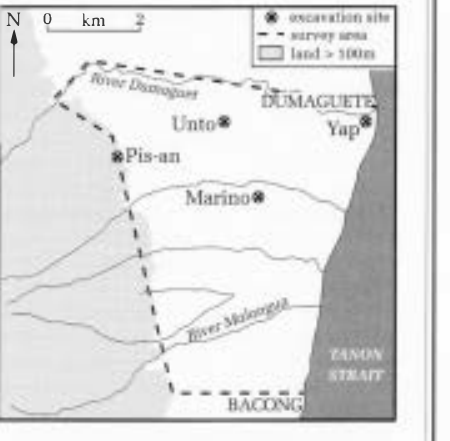
Figure 4 The Dumaguete-Bacong archae­ ological survey area and the location of excavation